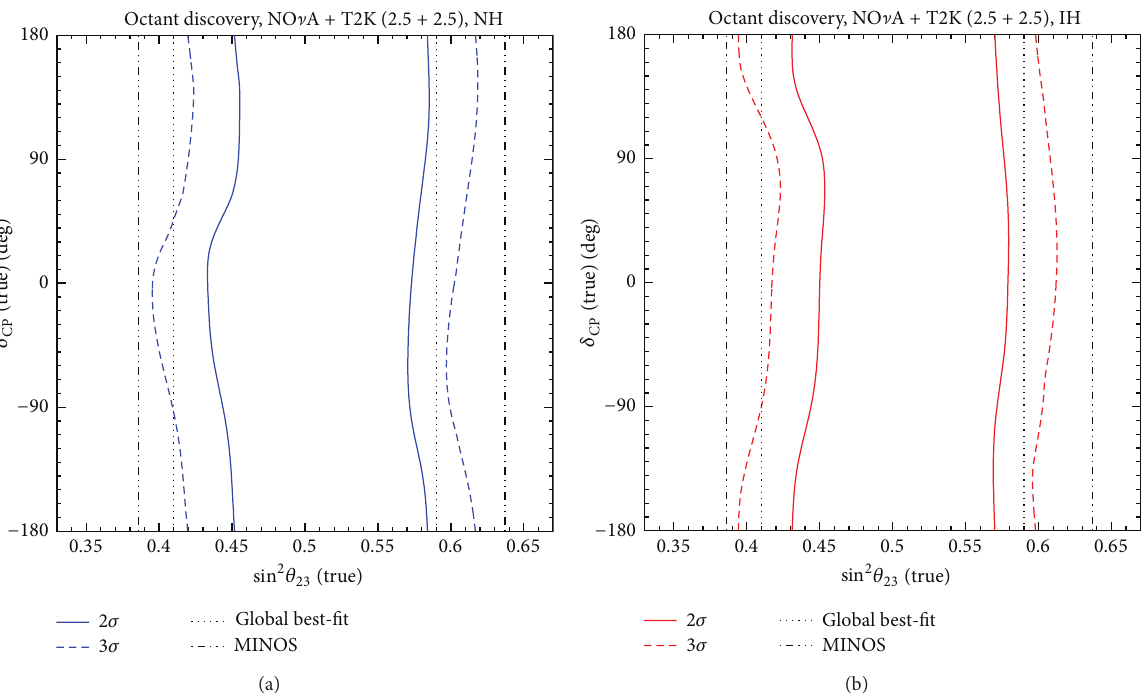
Figure 11: Octant resolving capability in the true sin 2 𝜃 23 -true 𝛿 plane for the combined 3 ] + 3 ] runs of NO ] A and 2.5 ] + 2.5 ] runs of T2K. CP Both 2𝜎 and 3𝜎 CL contours are plotted. The vertical lines correspond to the best-fit values of global data and those of MINOS accelerator data. The left (right) panel corresponds to NH (IH) being the true hierarchy. This figure has been taken from